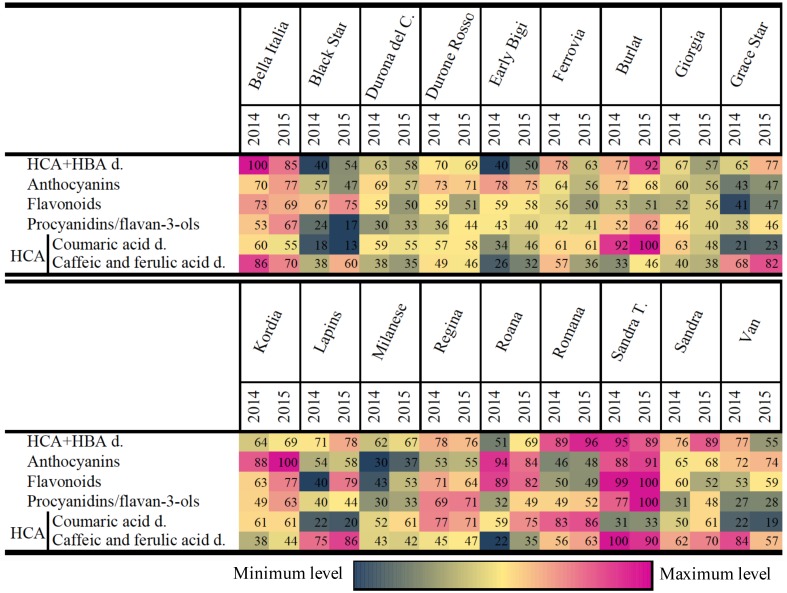
Heat map of the principal classes of metabolites that accumulate in each cultivar.The data show the proportion of each metabolite class (percentage) and the year trend in the different cultivars. The colour gradient ranges from blue (low abundance) to red (high abundance). Legend: hydroxycinnamic acids, HCAs; hydroxybenzoic acids, HBAs; derivatives, d.; Durona del Chiampo, Durona del C; Sandra Tardiva, Sandra T.